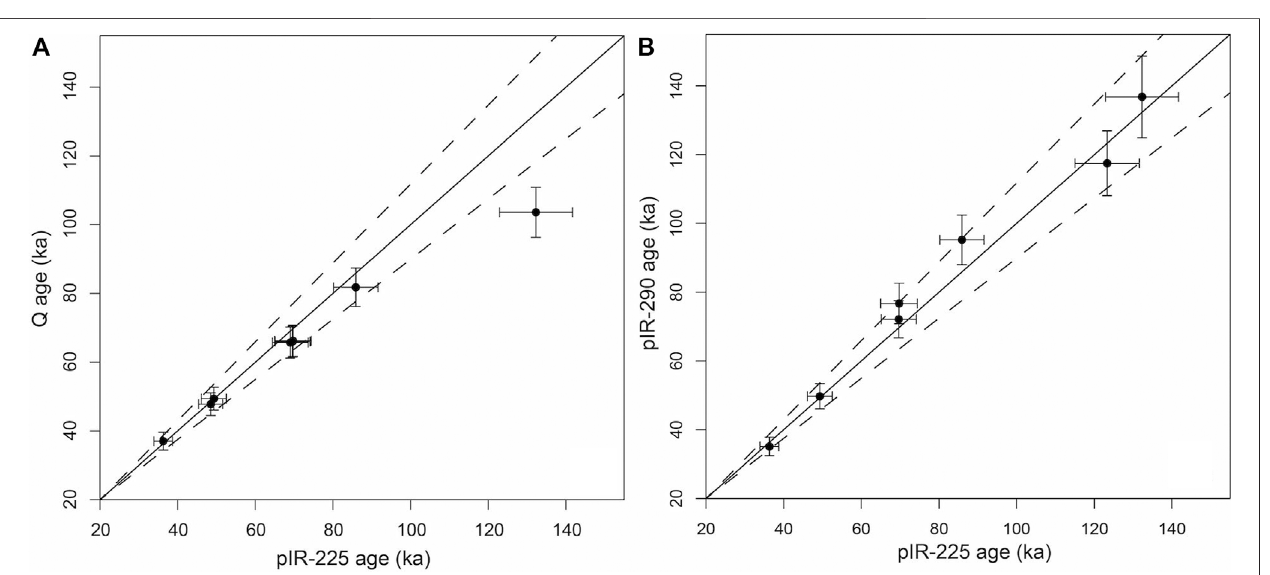
Frontiers in Earth Science |